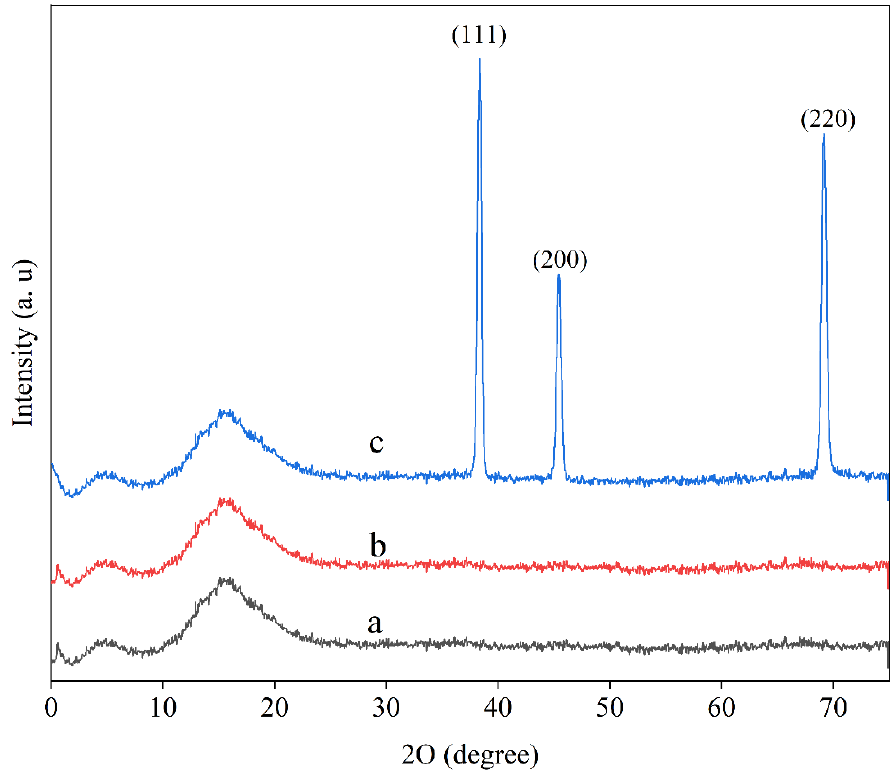
Figure 4. XRD spectra of ( a ) SPI, ( b ) SPI/PG, ( c ) SPI/PG/SNPs films.